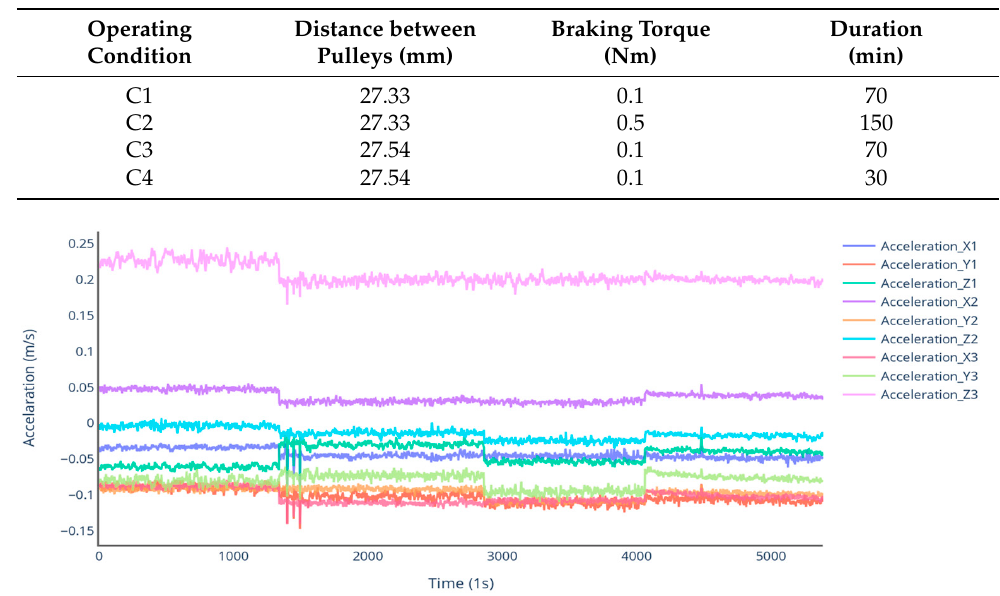
Figure 4. Raw signals from each operating condition (20 min per condition).